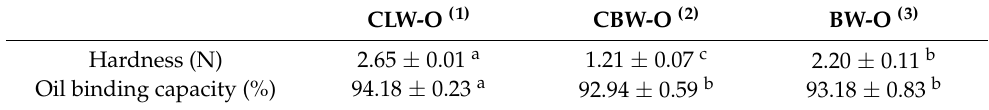
Table 2. Texture properties and oil binding capacity of oleogels with different wax